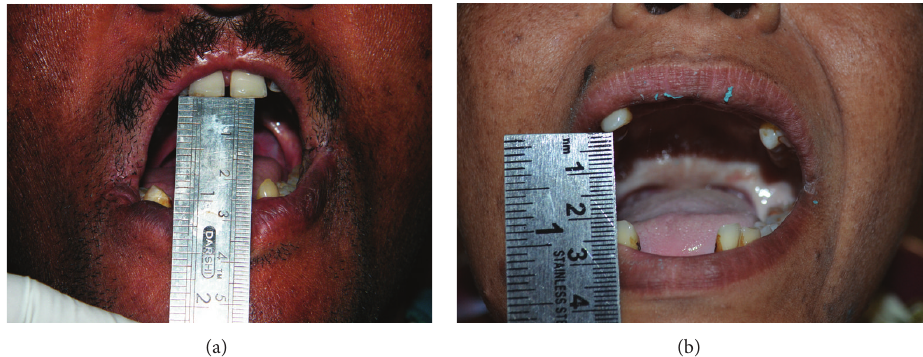
Figure 1: Maximum mouth openings.